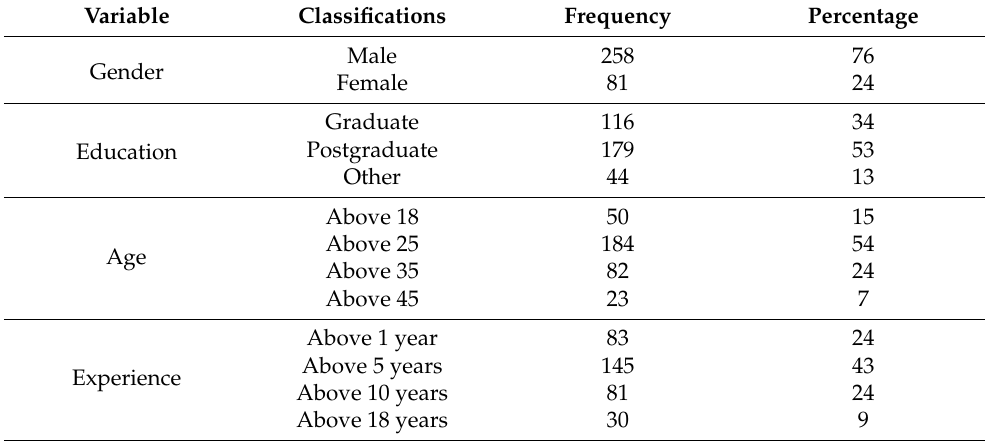
Table 1. Demographic information (n = 339).